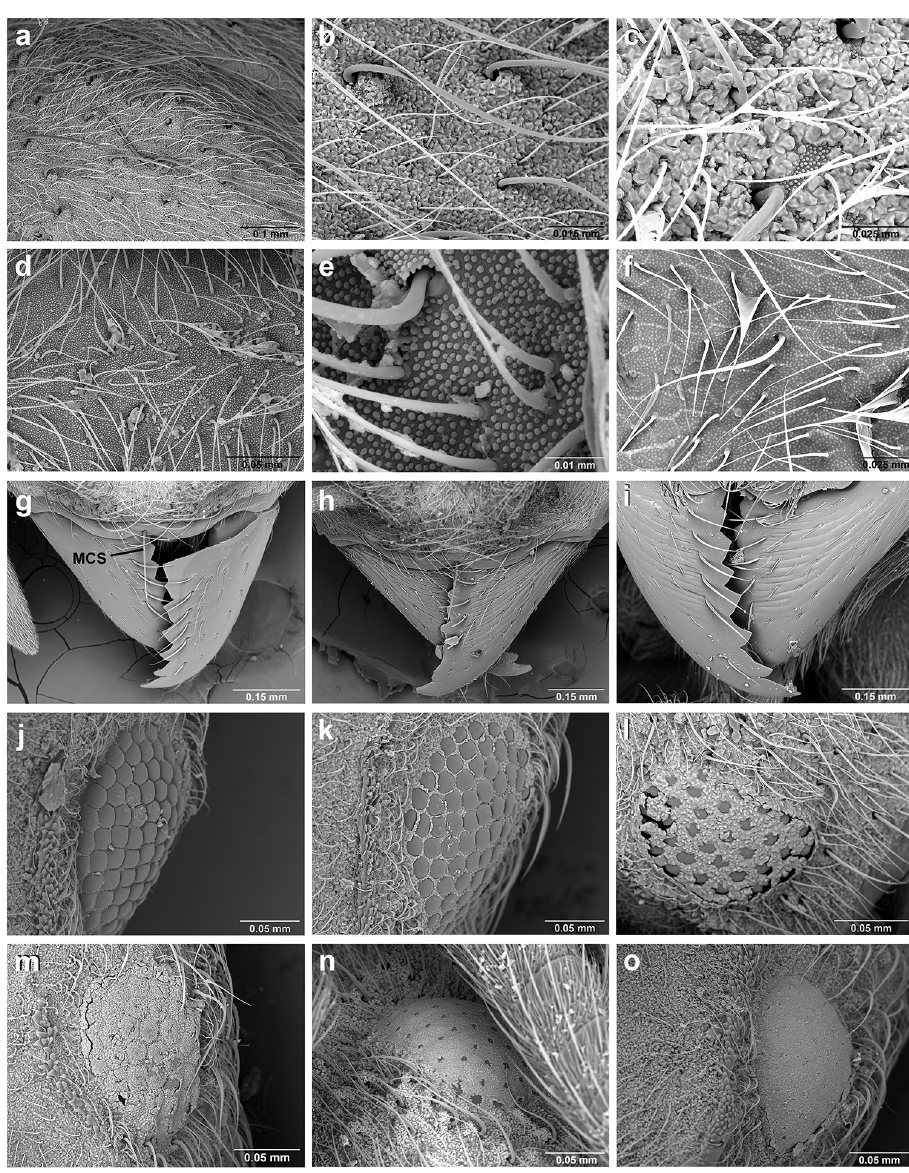
Figure 6. Sericomyrmex morphology, SEM images: integument, mandibles, and eyes. Integument: a , b, c adult worker integument d , e callow worker integument; f male integument. Mandibles: g smooth ( S. parvulus worker) MCS median clypeal seta h striate ( S. saussurei worker) i faintly striate ( S. mayri cal- low worker). Eyes: j, k eyes without white layer; l partially covered eye ( S. parvulus ) m completely covered eye, but individual ommatidia still discernible ( S. opacus ) n eye with thick white layer, ommatidia visible through narrow holes ( S. saussurei ) o eye completely covered with white layer, individual ommatidia not visible ( S. saussurei